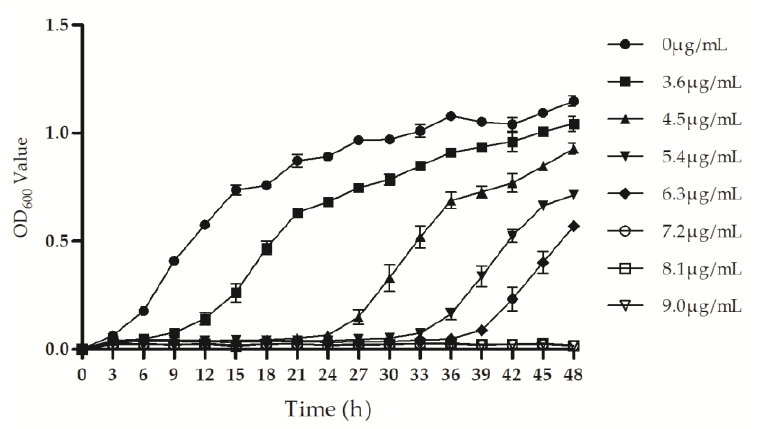
Figure 2. The 48 h growth curve of Psa treated with different concentrations of ethylicin.